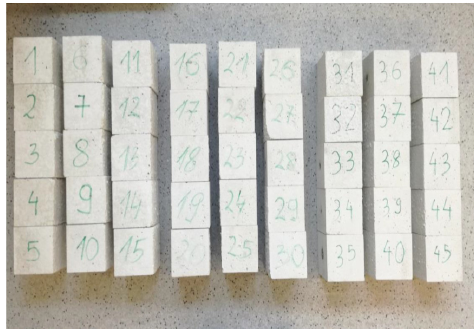
Figure 5. Samples for strength tests, Lot A (No. 1–15), B (No. 16–30), and C (No. 31–45).